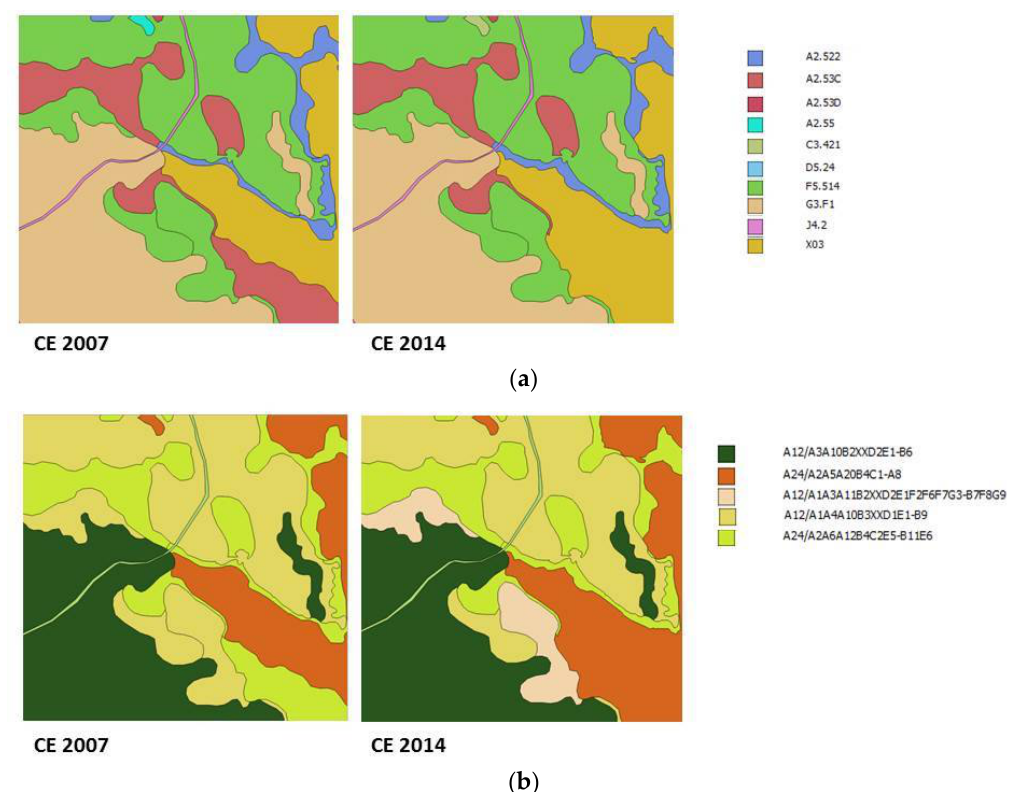
Figure 19. The case of pine encroachment in Mediterranean maquis in the CE site. In this specific case, being an encroachment of low intensity, the same EUNIS class (F5.514—Lentisc brush) was used in 2007 and in 2014 ( a ). With LCCS ( b ), the original class A12/A1.A4.A10.B3.XX.D1.E1-B9 (Broadleaved evergreen medium/high thicket) changed into A12/A1.A3.A11.B2.XX.D2.E1.F2.F6.F7.G3-B7F8G9 (Needleleaved evergreen open low trees (woodland) with closed medium/high shrubs).